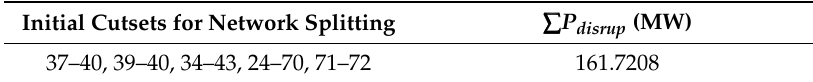
Table 6. Initial cutsets for Case